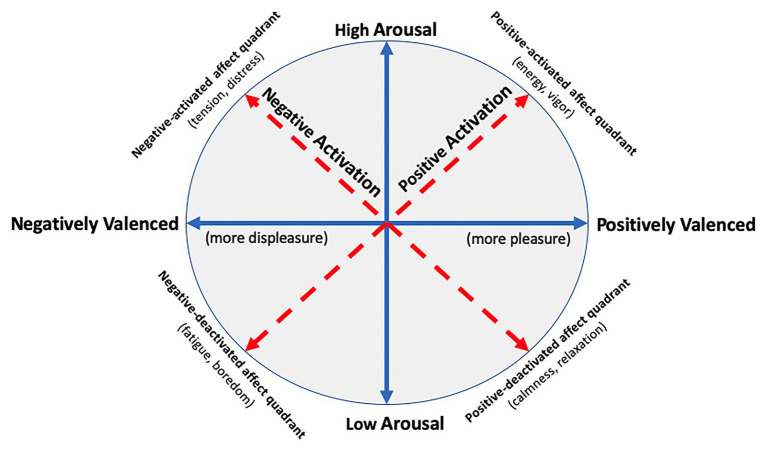
Core affect as depicted by the unrotated and rotated circumplex models (adapted from Ekkekakis, 2013). Solid arrow lines (blue) represent the dimensions of the unrotated circumplex model of affect (Russell, 1980), and dotted arrow lines (red) represent the dimensions of the rotated circumplex model of affect (Watson and Tellegen, 1985) using the revised labels for each bipolar dimension (Watson et al., 1999). As depicted, the dimensions of the unrotated circumplex model generate four quadrants and certain measures of affect, such as the Physical Activity Affect Scale (PAAS; Lox et al., 2000), measure constructs that map onto these quadrants.